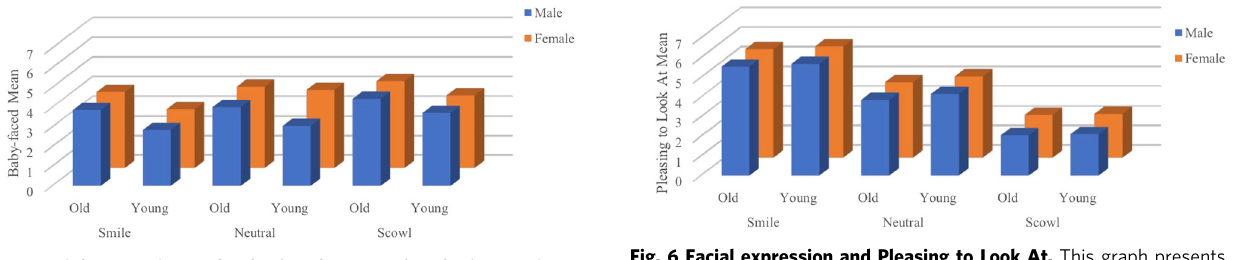
Fig. 4 Facial expression and Baby-faced/mature-faced. This graph presents interaction of facial expression, age, and gender on mean ratings of Baby-faced/mature-faced. age and gender were signi fi cant. The following sections present the results for the univariate main effects of age and gender, and the interaction effects of facial expression, age, and gender for the perceptions of the Big-Five personality traits.